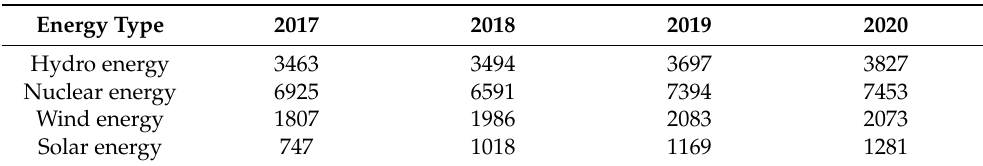
Table 2. Annual usage hours of nonfossil energy power generation equipment in China from year